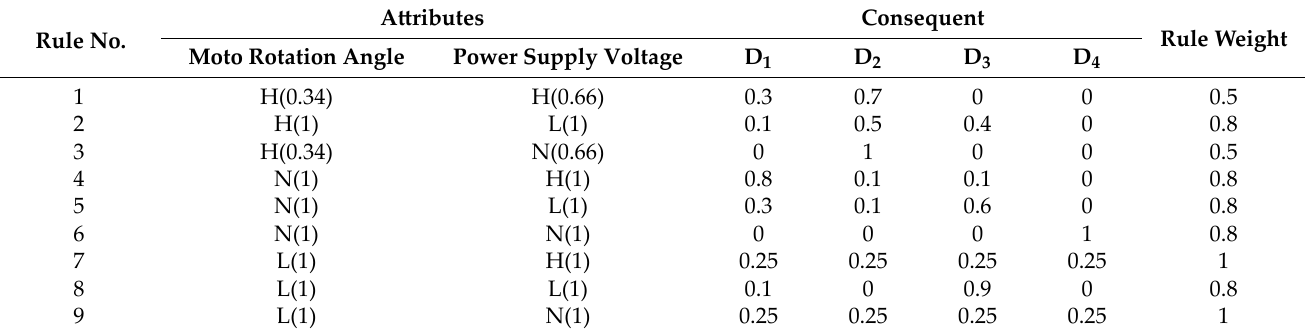
Table 12. BRB for adding supplementary